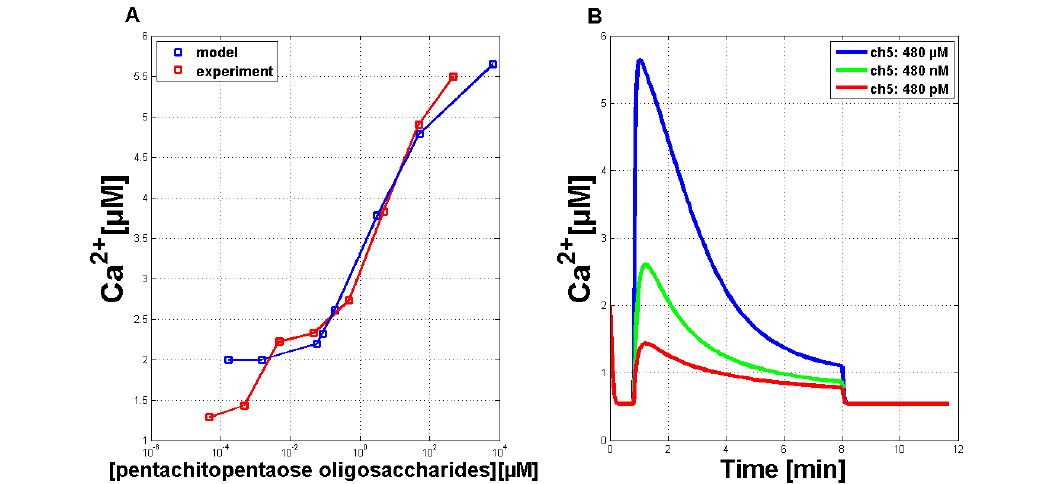
Figure 4. Quantitative comparison of measured Ca 2+ transients and simulations of Ca 2+ transients with the adapted Li and Rinzel model. ( A ) Comparison of experimental (red curve) and simulated (blue curve) dose-response relationship for the Ch5 elicitor. ( B ) Simulations of single Ca 2+ curves in answer to treatment with reduced stimulus activation, in analogy to the reduced Ch5 concentrations as used in the